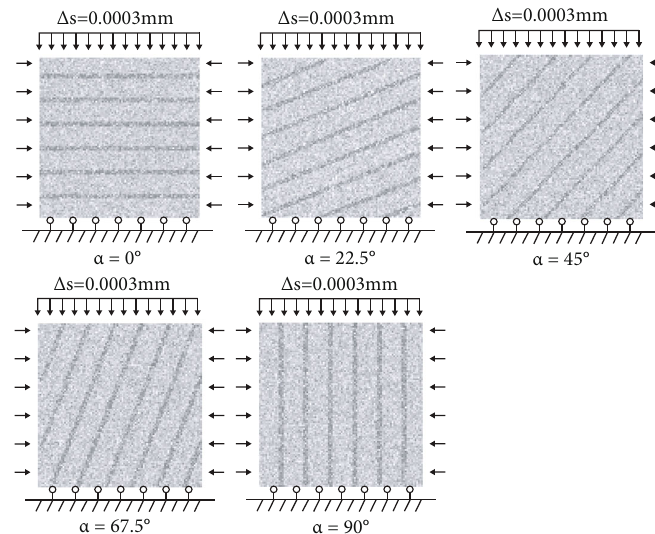
Figure 5: Schematic diagram of model